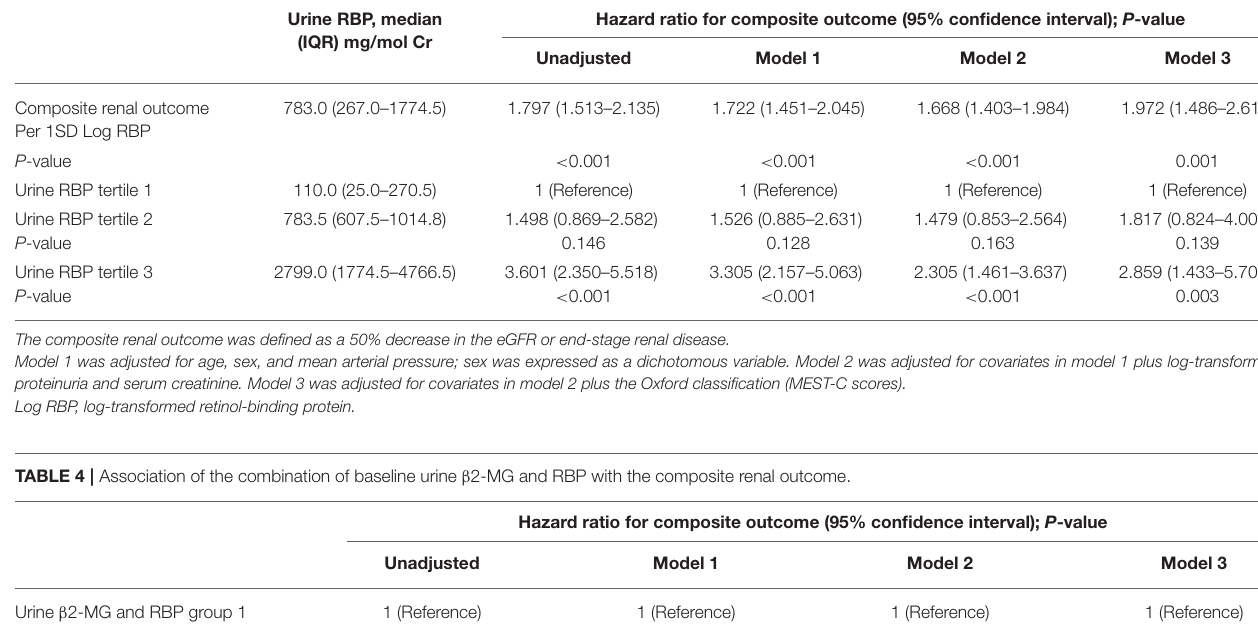
TABLE 3 | Association of baseline urinary RBP levels with the composite renal outcome.